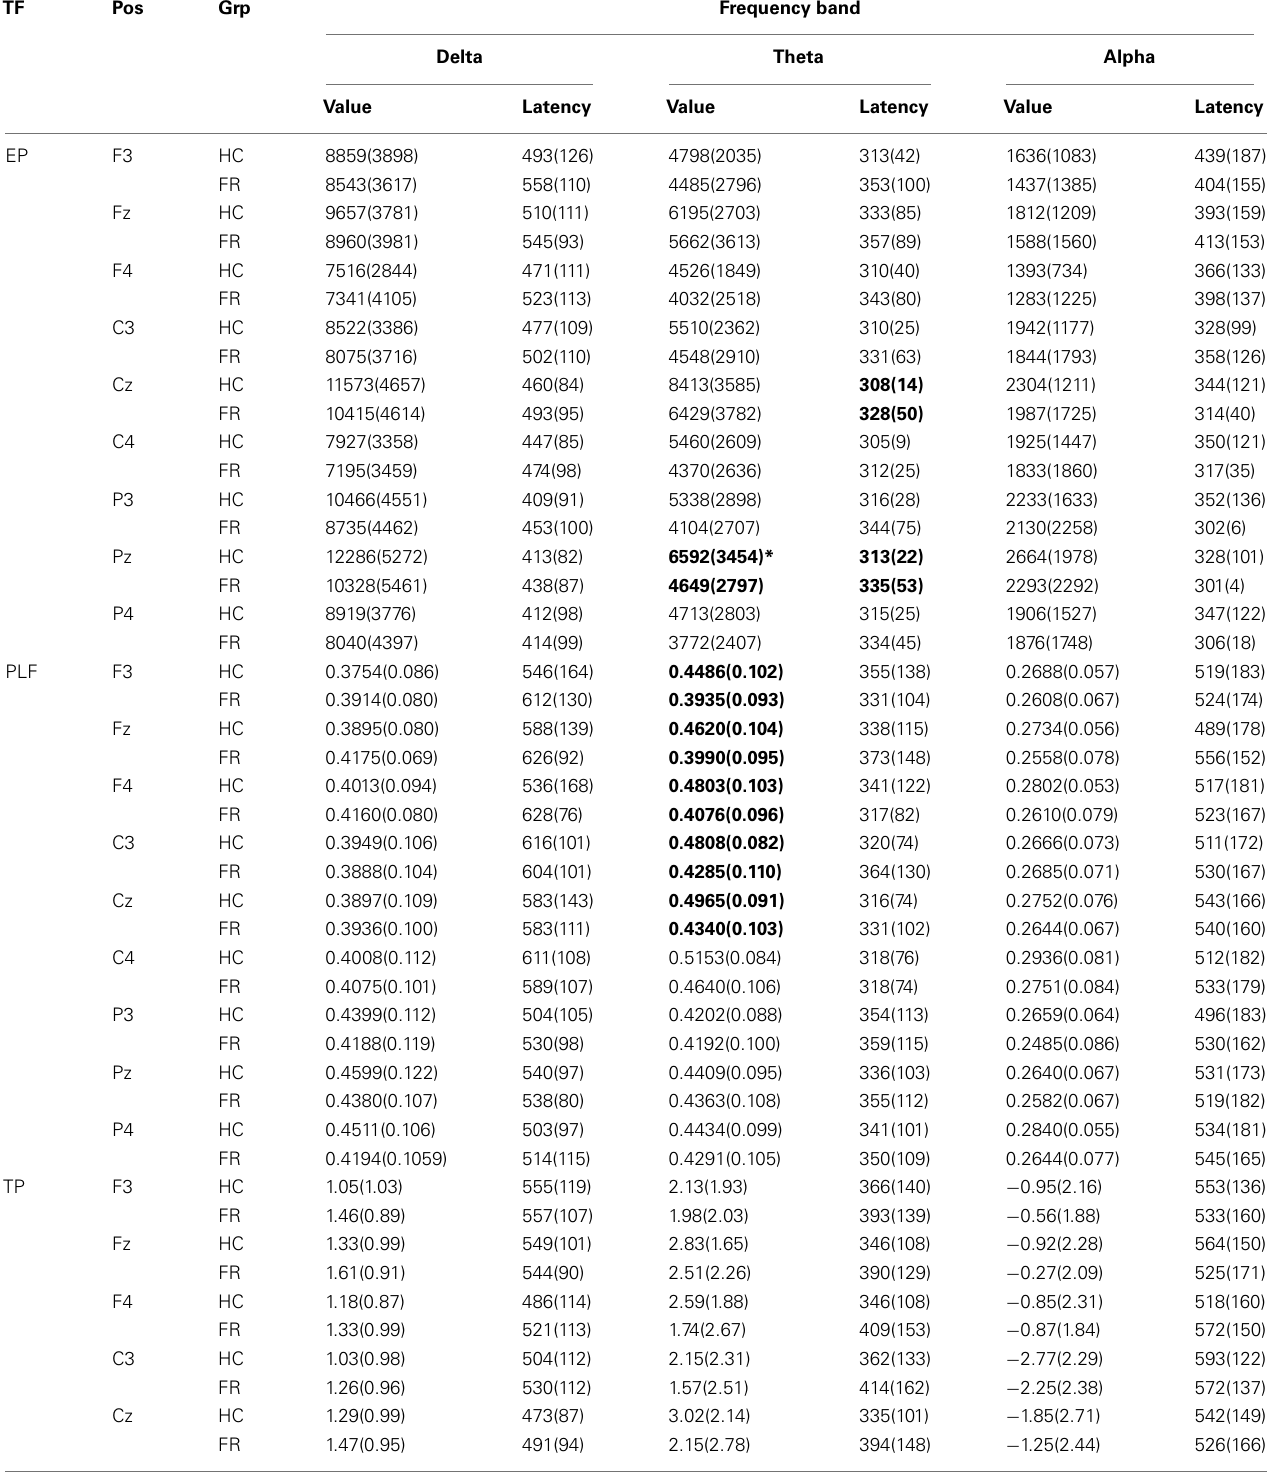
TableA3 | Means and SD (in parentheses) for time–frequency decomposition measures. Time range